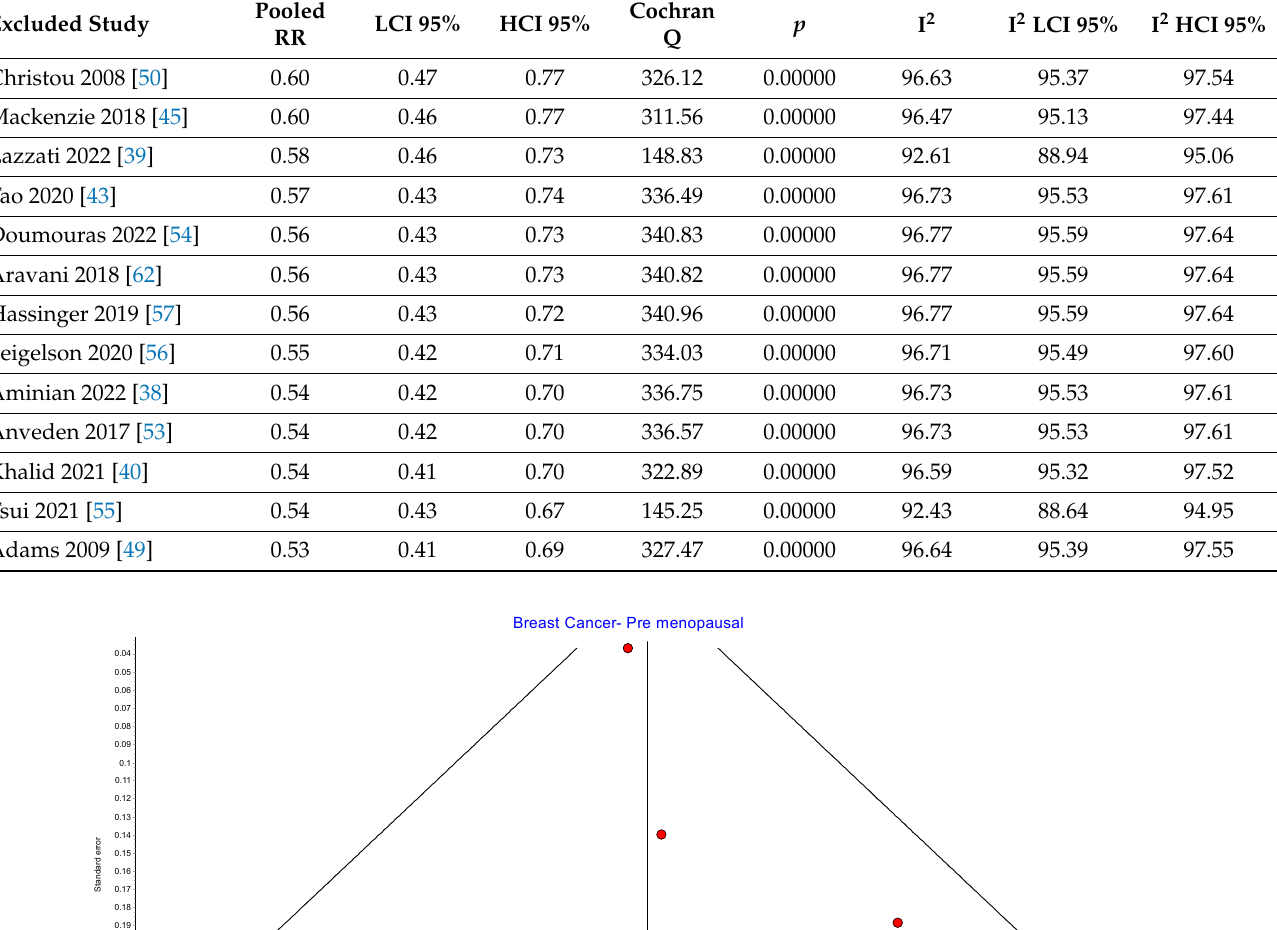
Table A4. Overall breast cancer random effects model sensitivity analysis.